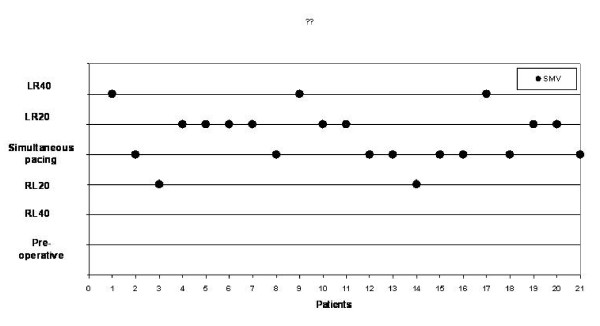
The best VV-interval after optimization in each patient in this study (n = 21). With sequential pacing highest systolic maximal velocity (SMV) value was reached in 13 patients (62%).